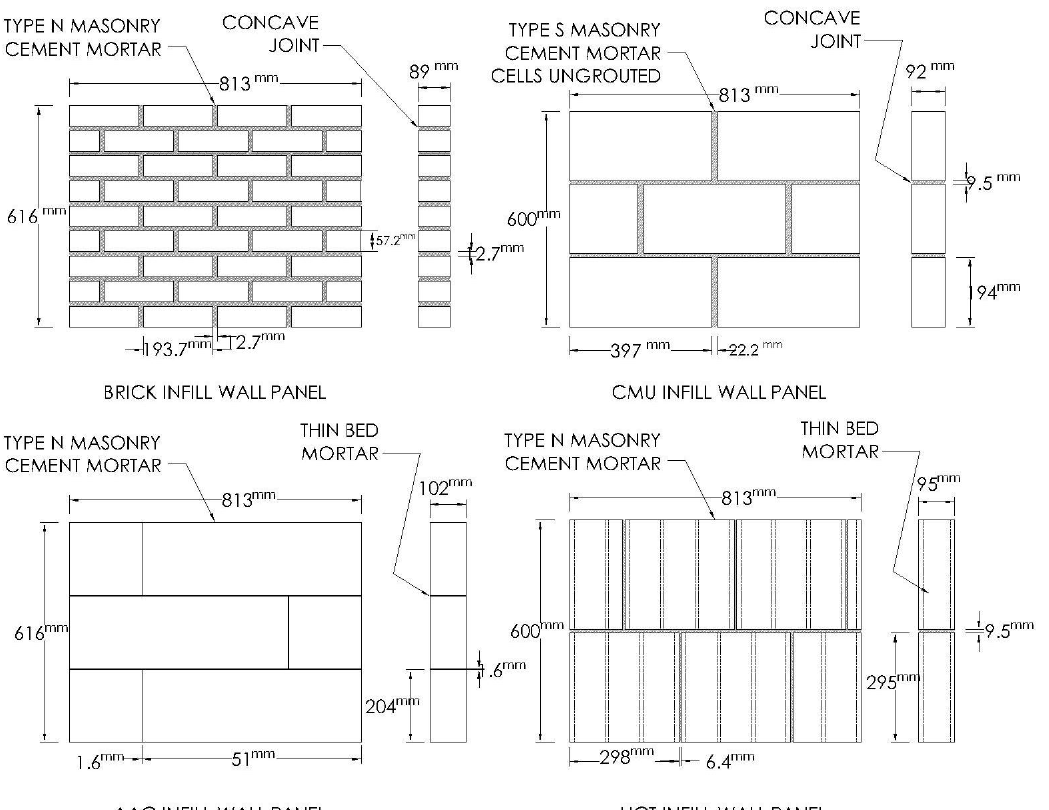
Figure 3. Masonry infill wall specimens.